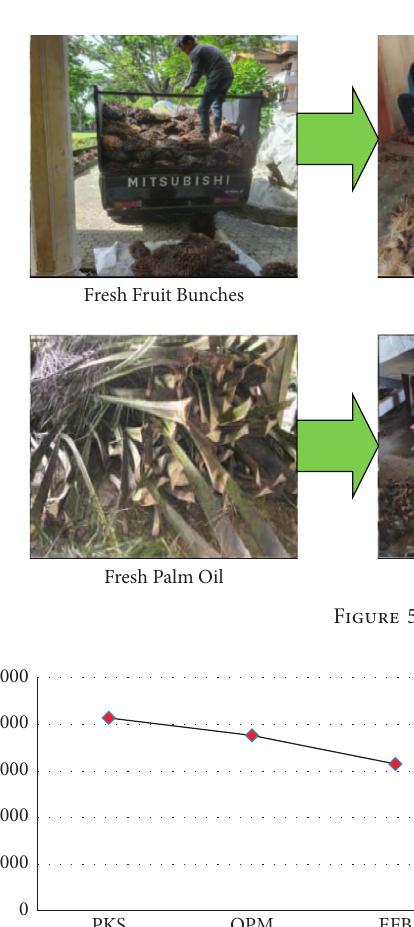
Figure 4: Types of solid waste biomass, palm oil. (a) PKS. (b) OPM. (c) EFB.